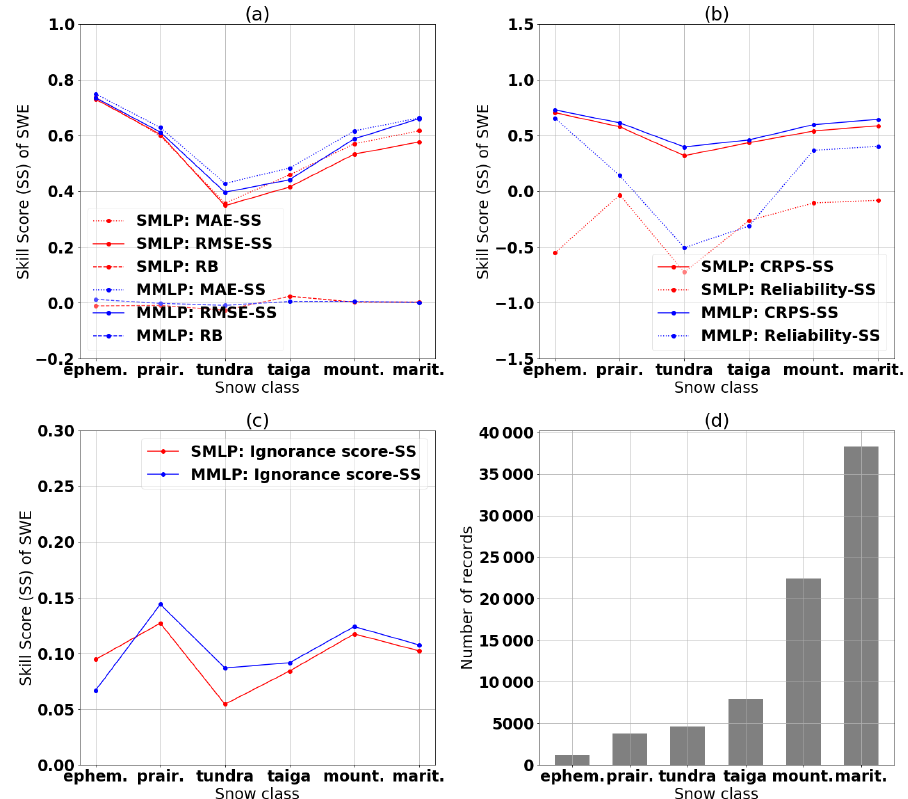
Figure 12. Comparison of the performance of the single MLP (SMLP) and multiple MLP (MMLP) models using (a) the skill score (SS) of the MAE, RMSE, and the relative bias (RB), (b) the skill score of the CRPS and reliability, and (c) the skill score of the ignorance score evaluated for the different snow classes. All results are for the testing data set. (d) The number of records in each snow class within the testing data set.